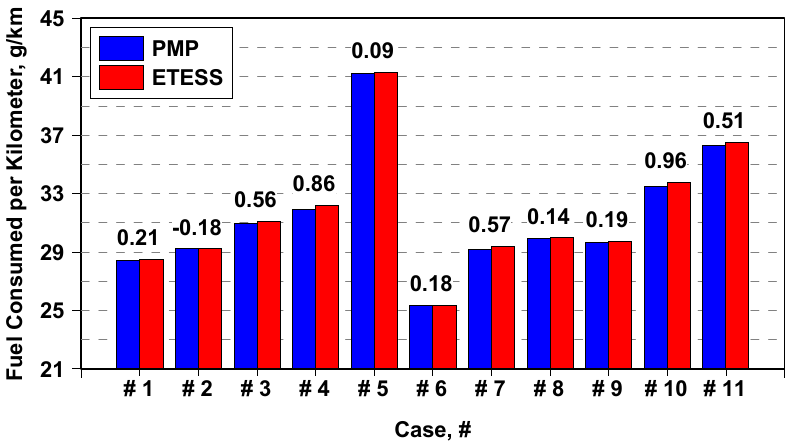
Figure 12. Assessment of kilometric consumed fuel in the cases of Table 3 between off-line ETESS and PMP.